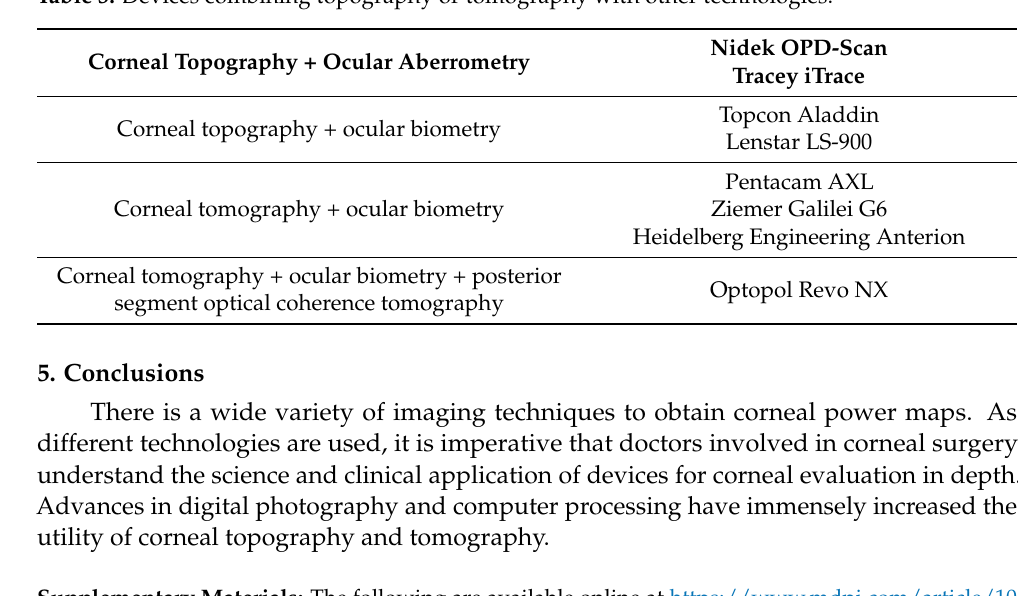
Table 3. Devices combining topography or tomography with other